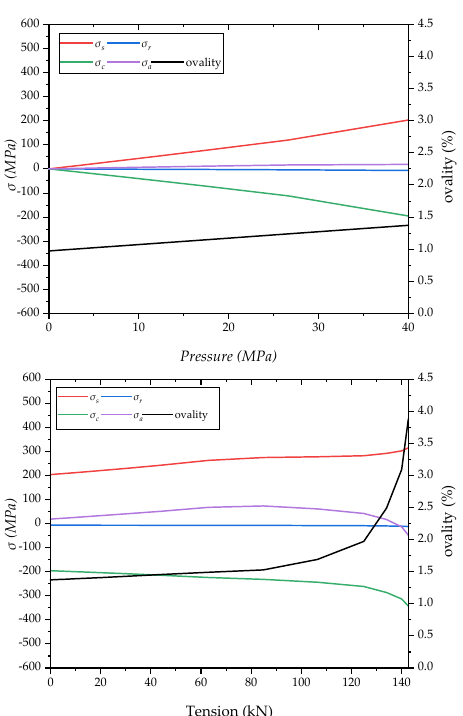
Figure 16. Stress changing history at integration point A (P → T loading